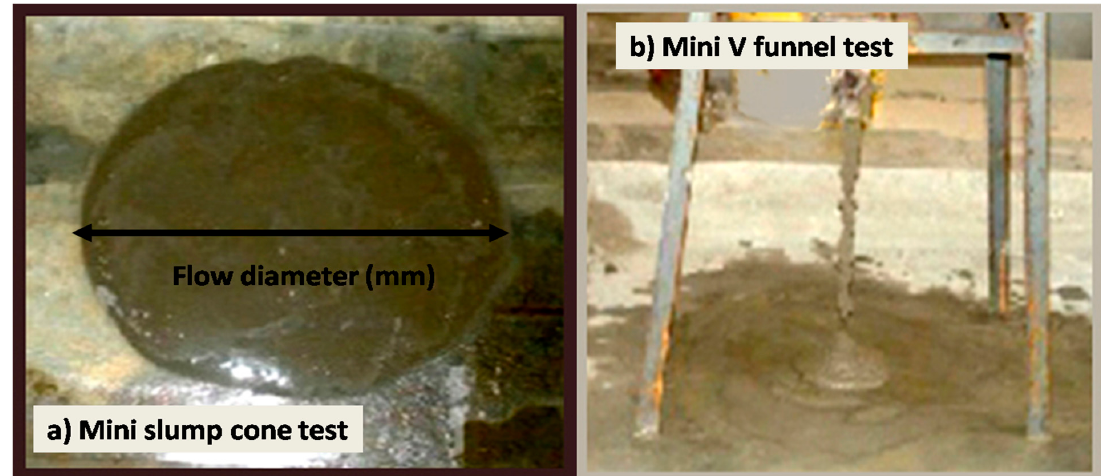
Figure 3. Fresh state behavior of the SCGM. ( a ) Mini slump cone test; ( b ) Mini V funnel test.